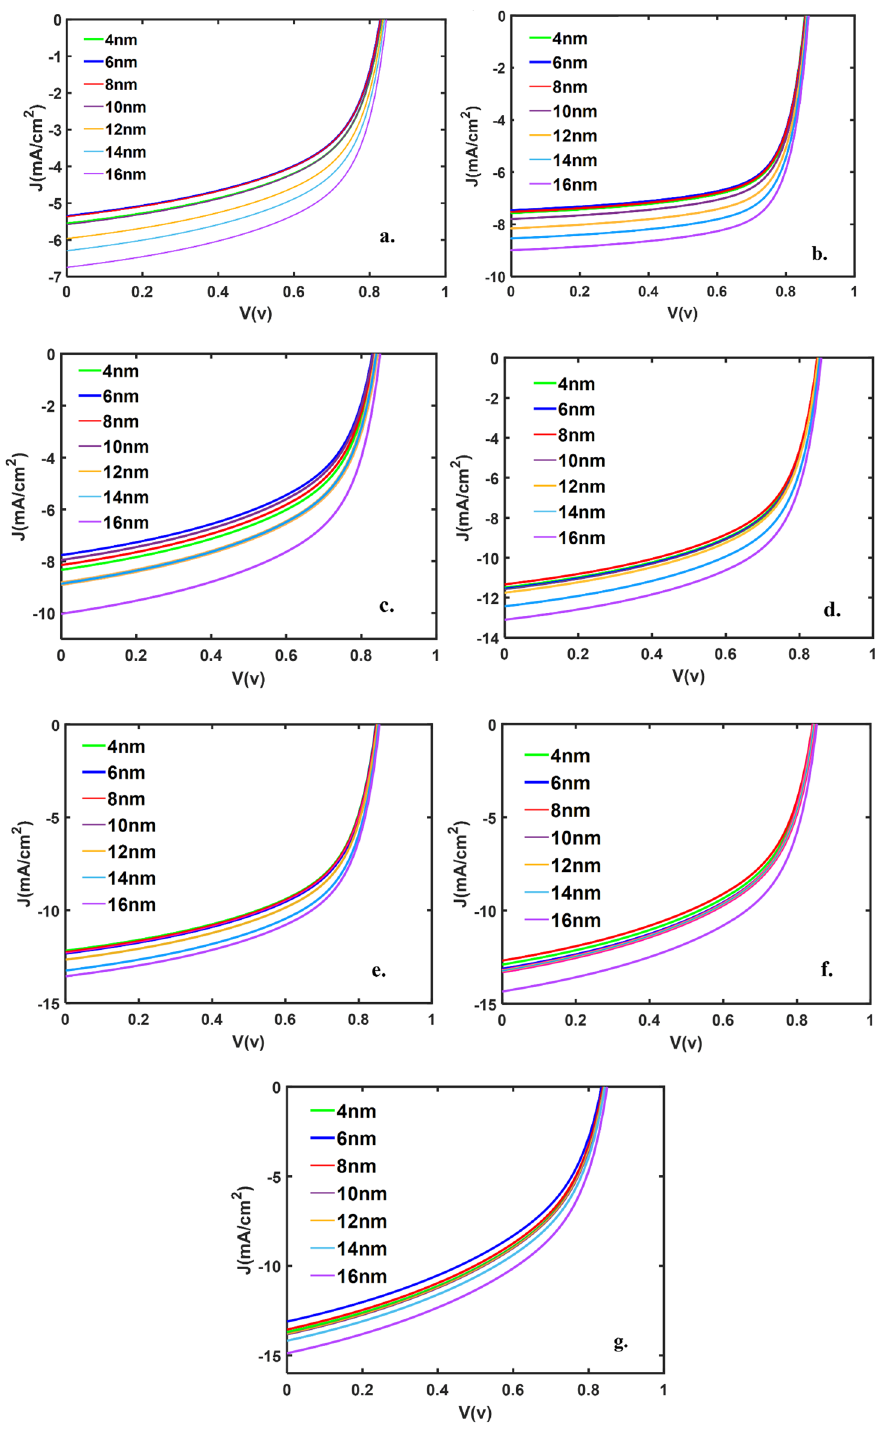
Figure 6. J-V curve for devices with a thickness of active layer ( a ) 53 nm, ( b ) 59 nm, ( c ) 72 nm, ( d ) 91 nm, ( e ) 100 nm, ( f ) 114 nm, ( g ) 143 nm, for various ‘d m ’